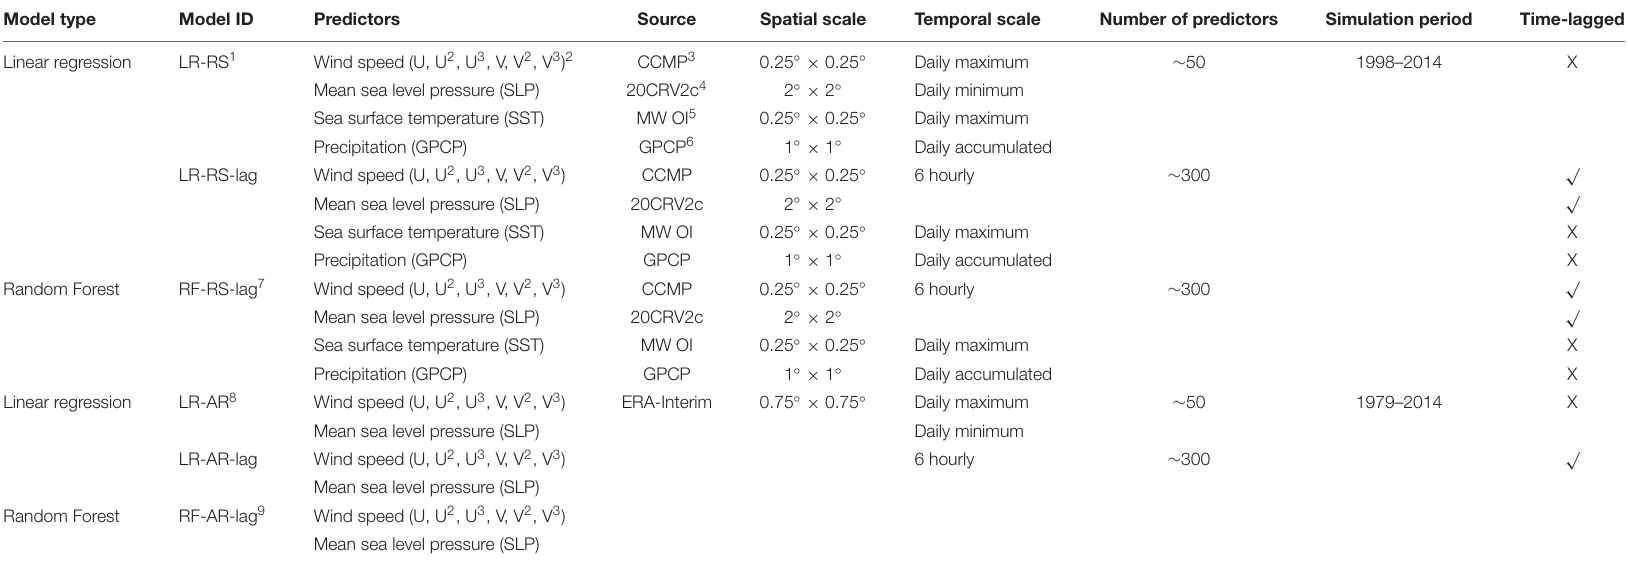
TABLE 1 | Description of implemented data-driven models.